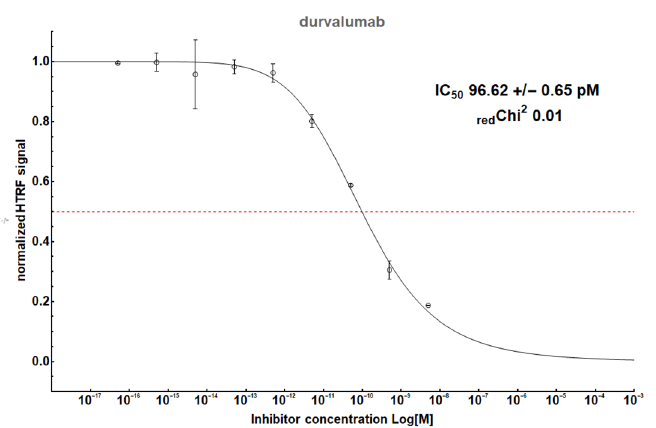
Figure A2. The HTRF analysis result for a therapeutic antibody, durvalumab.